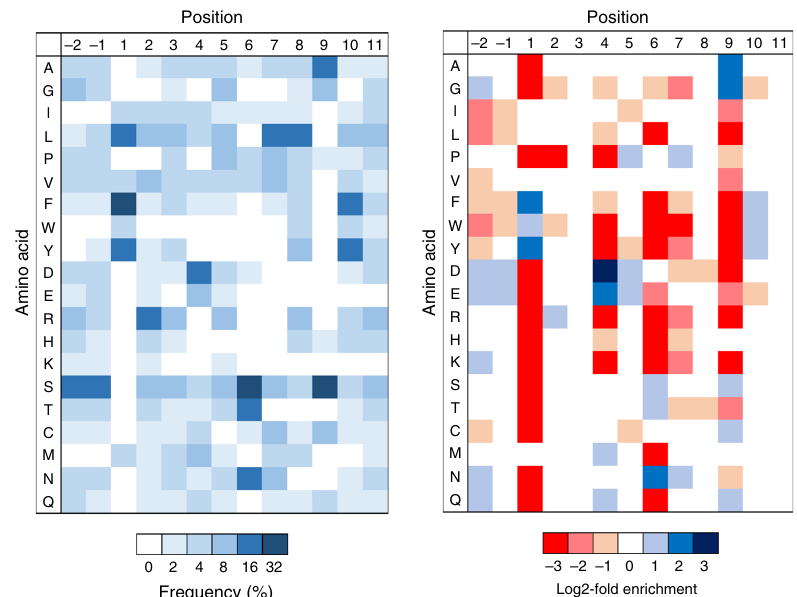
Fig. 4 Discovery of preferences at TCR contacts and positions outside the peptide core. Unweighted heat maps of log2-fold enrichment and/or positional percent frequency of each amino acid for all peptides in round fi ve of selection of a randomized 13mer HLA-DR401 library determined to bind in the third peptide register ( n = 3,374 unique peptides).